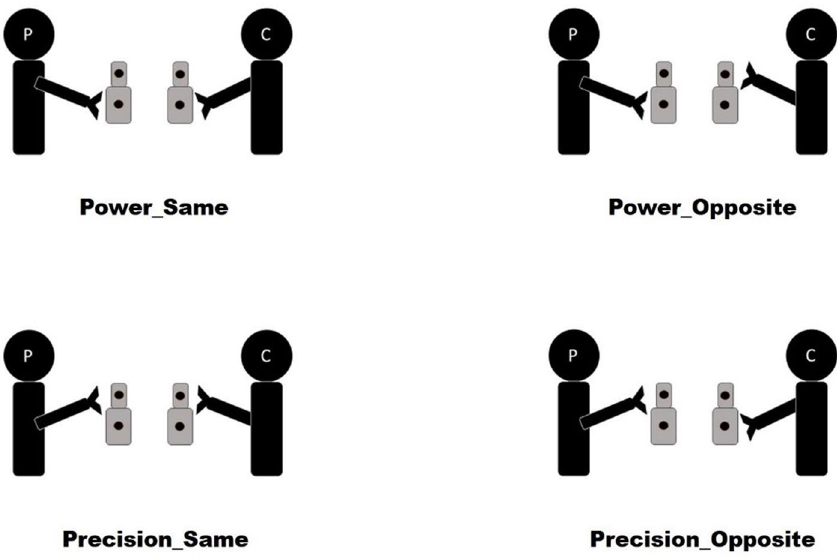
Figure 2. Graphical representation of the Joint Grasping task. Power and Precision trials are considered from the point of view of the Participant (P, on the left side). Opposite and Same movements are considered from the point of view of both the Participant and the Confederate (C, on the right side).